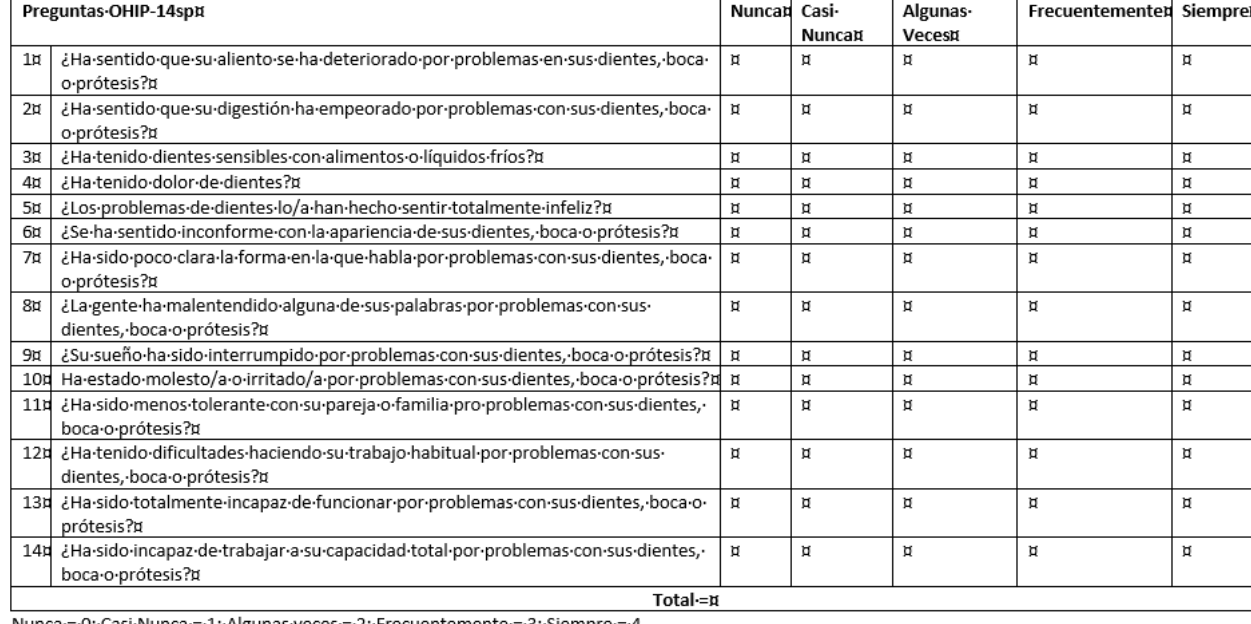
Figure 2. Spanish version of the oral health impact profile 14 questionnaire (OHIP-14sp).